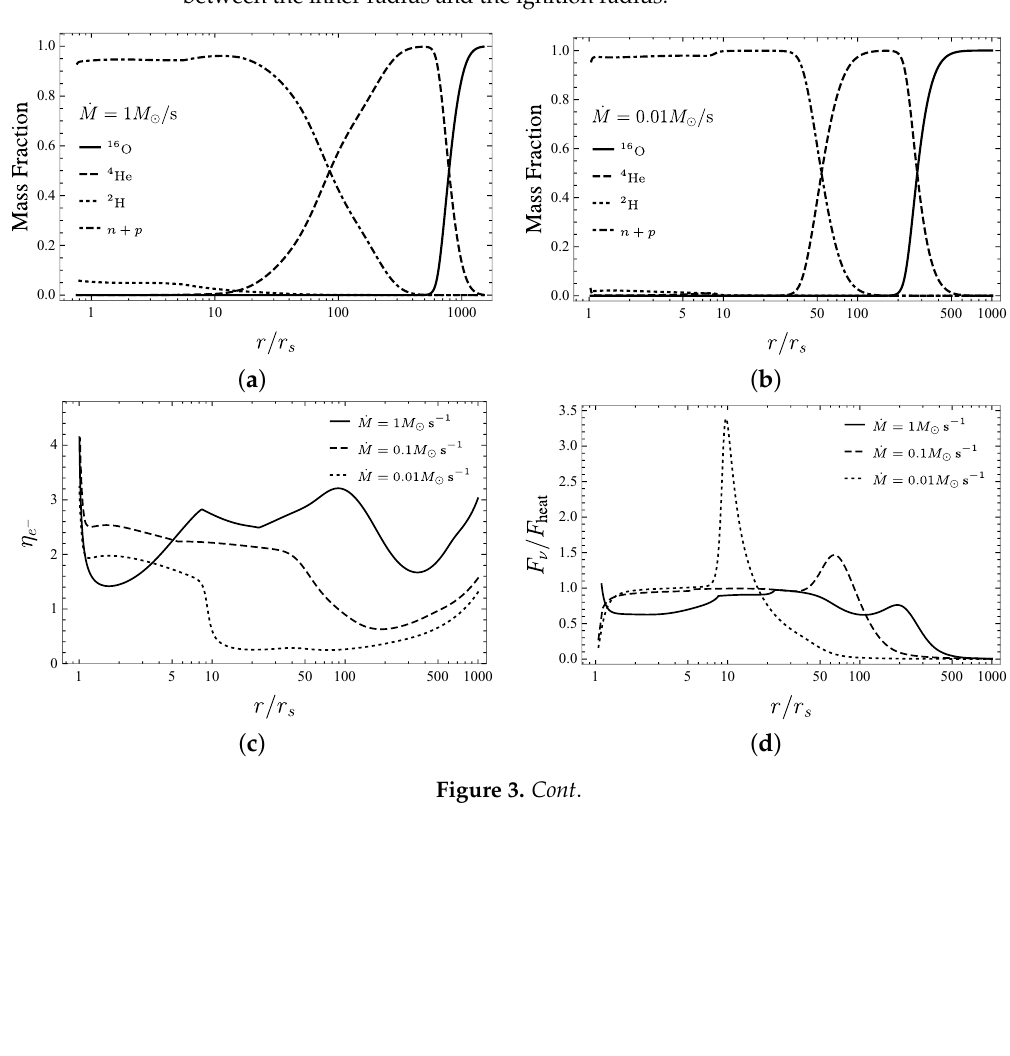
Figure 2. Total number emissivity for electron and positron capture ( p + e − → n + ν e , n + e + → p + ¯ ν e ) and electron–positron annihilation ( e − + e + → ν + ¯ ν ) for accretion disks with ˙ M = 0.1 M (cid:12) s − 1 between the inner radius and the ignition radius.